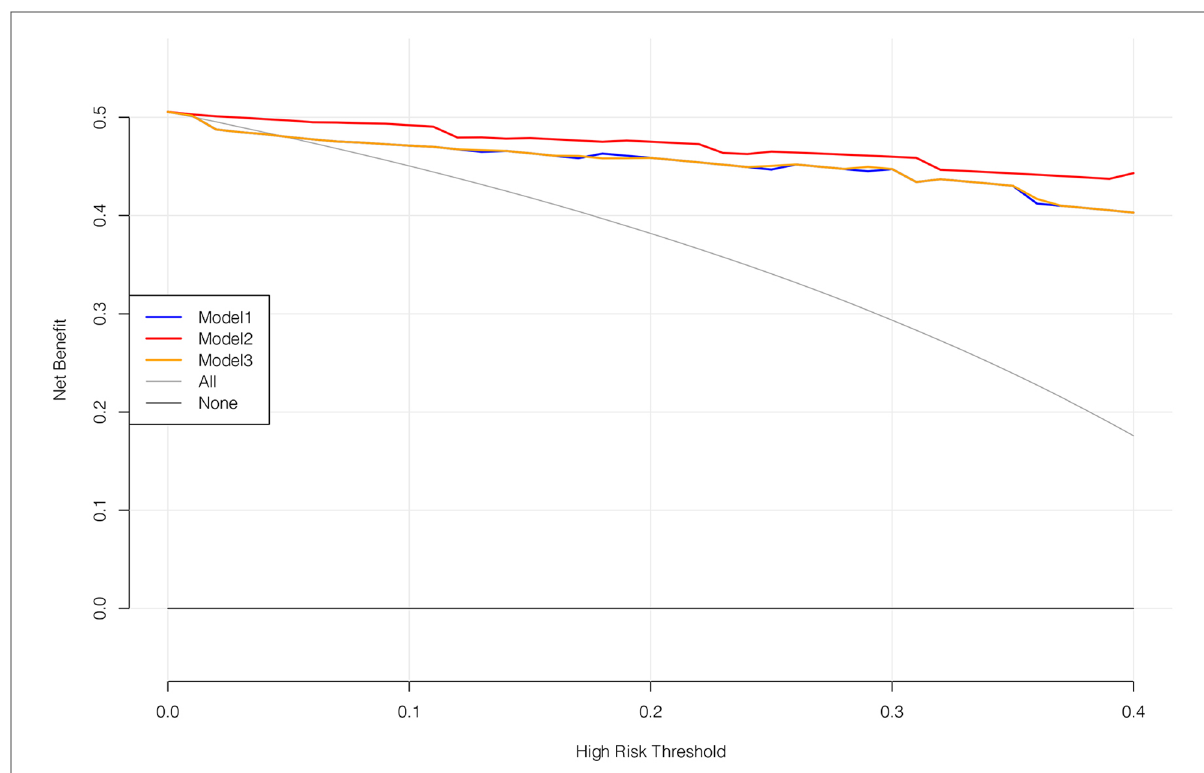
FIGURE 4 Decision curve analysis. Model 1 includes the age, baseline AL, pupil diameter, time spent outdoors, time spent on near work, and ortho-k brands. Model 2 is the model we constructed. Model 3 includes the age, baseline AL, pupil diameter, time spent outdoors, and time spent on near work. Among the three models, model 2 works